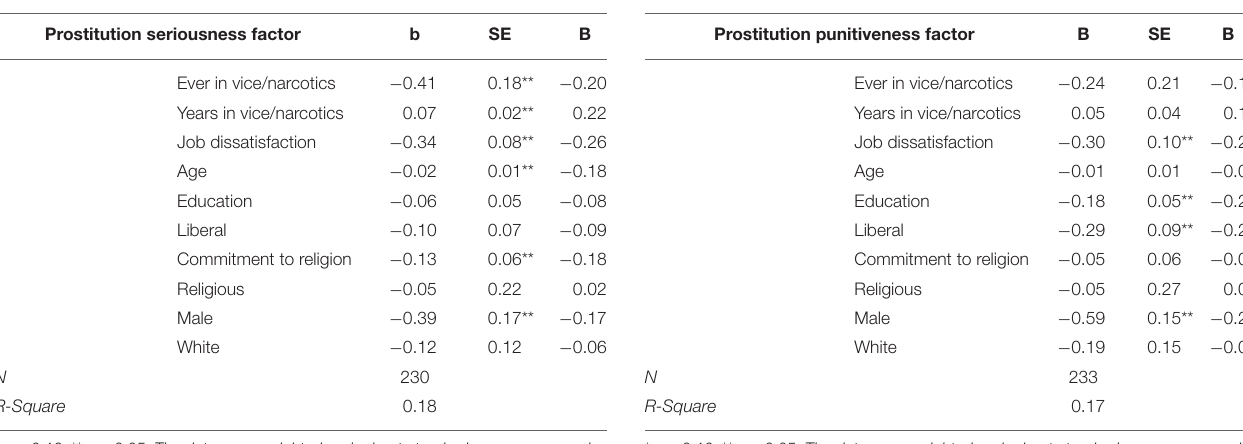
TABLE 4 | OLS regression model of prostitution seriousness attitudes. TABLE 5 | OLS regression model of prostitution punitiveness